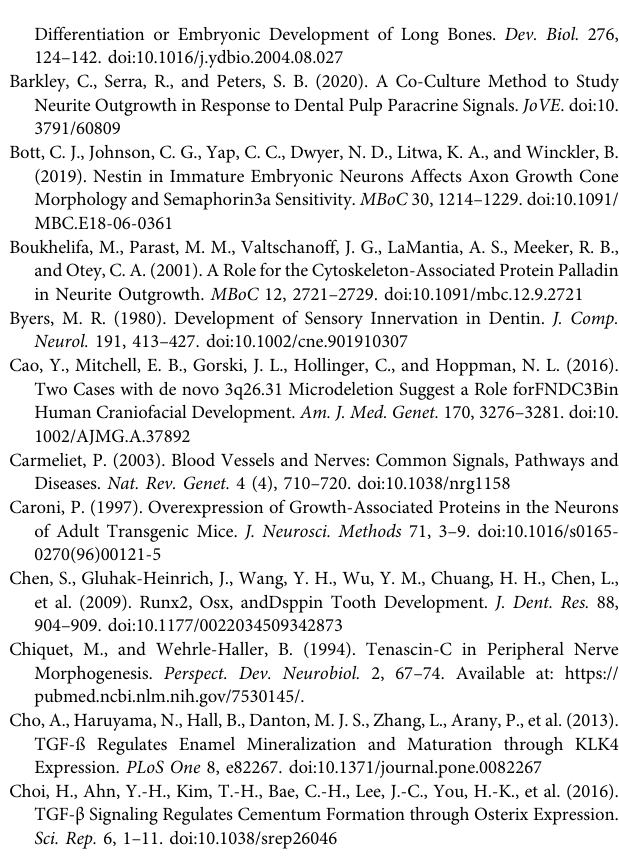
Supplementary Figure S1 | Nerve structures in postnatal teeth appear to be reduced in Tgfbr2 cko mice. Representative images of H&E-stained mandibular M1s from postnatal days 5, 7, 10, and 14. The black arrows in each image indicate hypothesized neuronal structures. Several other structures are present but are not indicated to prevent image crowding. N = 2 for P5 and N = 3 for P7, 10 and P14 for each genotype. The scale bar is 100 μ m. Supplementary Figure S2 | A volcano plot of the RNA-Seq data demonstrating that there were no signi fi cant differences in select genes between Osterix-Cre and Tgfbr2 cko samples. The volcano plot visually demonstrates that the Ngf, Gdnf, Nt-3, N fi c, and Dmp1 transcripts were not altered, as reported in the manuscript. Bdnf was not reported in the RNA-Seq analysis. RNA-Seq was performed on 4 Osterix- Cre and 4 Tgfbr2 cko samples. Supplementary Figure S3 | Representative image of Mypn in Osterix-Cre and Tgfbr2 cko P7 M1. Representative immuno fl uorescence images of myopalladin in P7 M1 Osterix-Cre and Tgfbr2 cko mice con fi rming axonal-speci fi c expression. N = 4 Osterix-Cre and Tgfbr2 cko